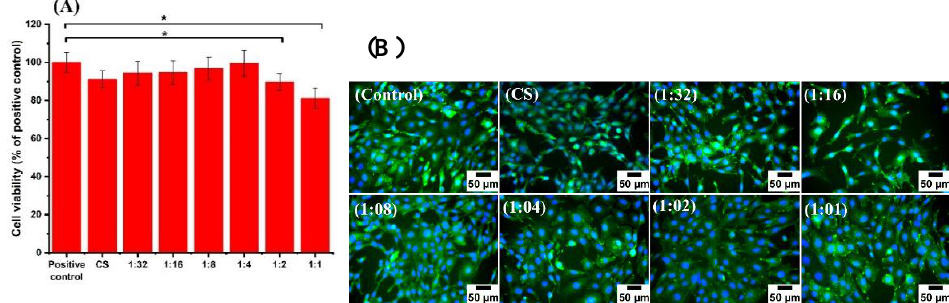
Figure 8. ( A ) Cell viability and ( B ) fluorescence microscope images of mouse embryonic fibroblasts (MEFs) cells cultured with the extracts of CS and Ga (III)-CS complexes for 24 h. The tissue culture plate was used as a control. Significant differences are represented by an asterisk (*).